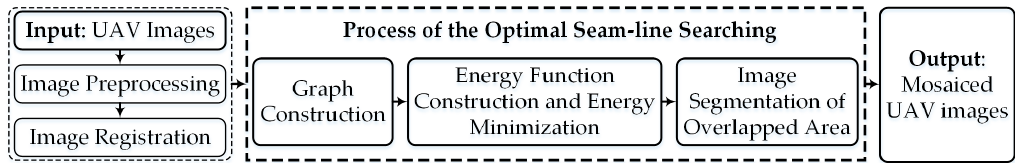
Figure 6. Flow chart of our method.